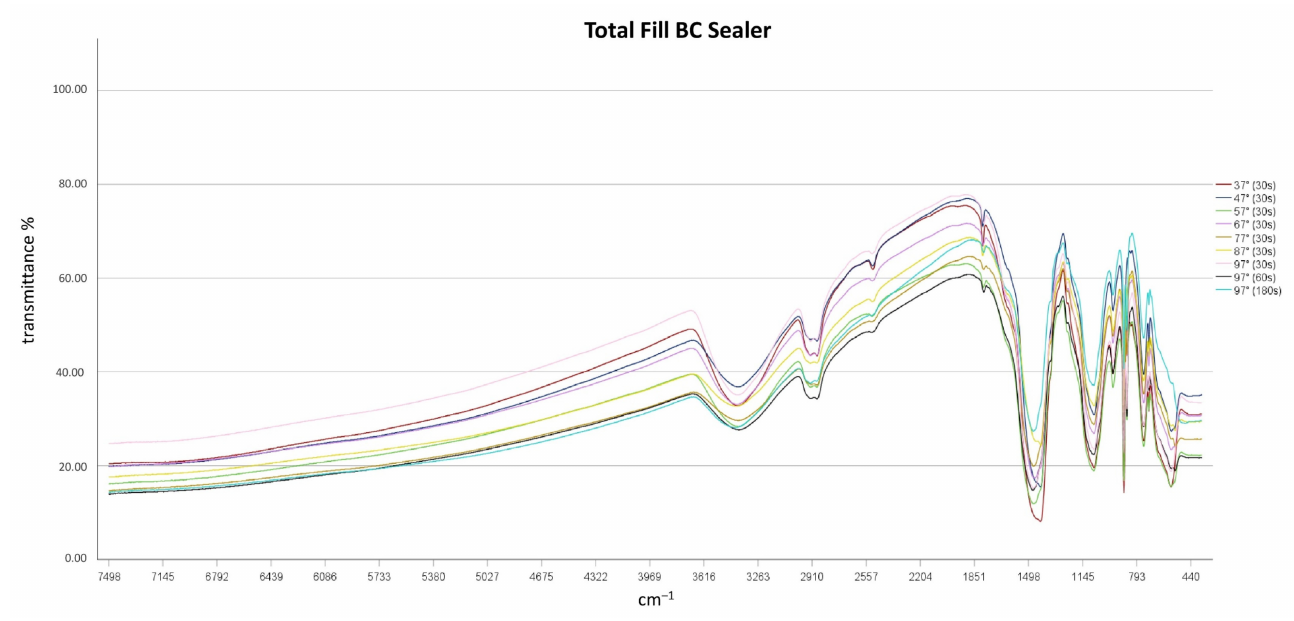
Figure 2. FT-IR spectroscopic plots of Total Fill BC